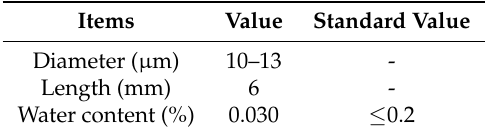
Table 5. Properties of basalt fiber (provided by